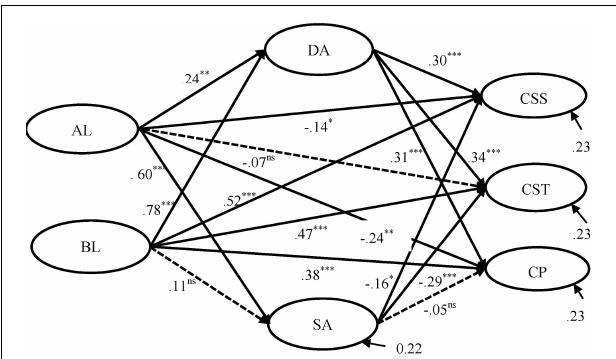
FIGURE 1 | Mediating effect of emotional labor on the effects of paternalistic leadership on teacher commitment. ∗∗∗ p < 0.001, ∗∗ p < 0.01, ∗ p < 0.05, ns, not significant. Dotted lines indicate non-significant